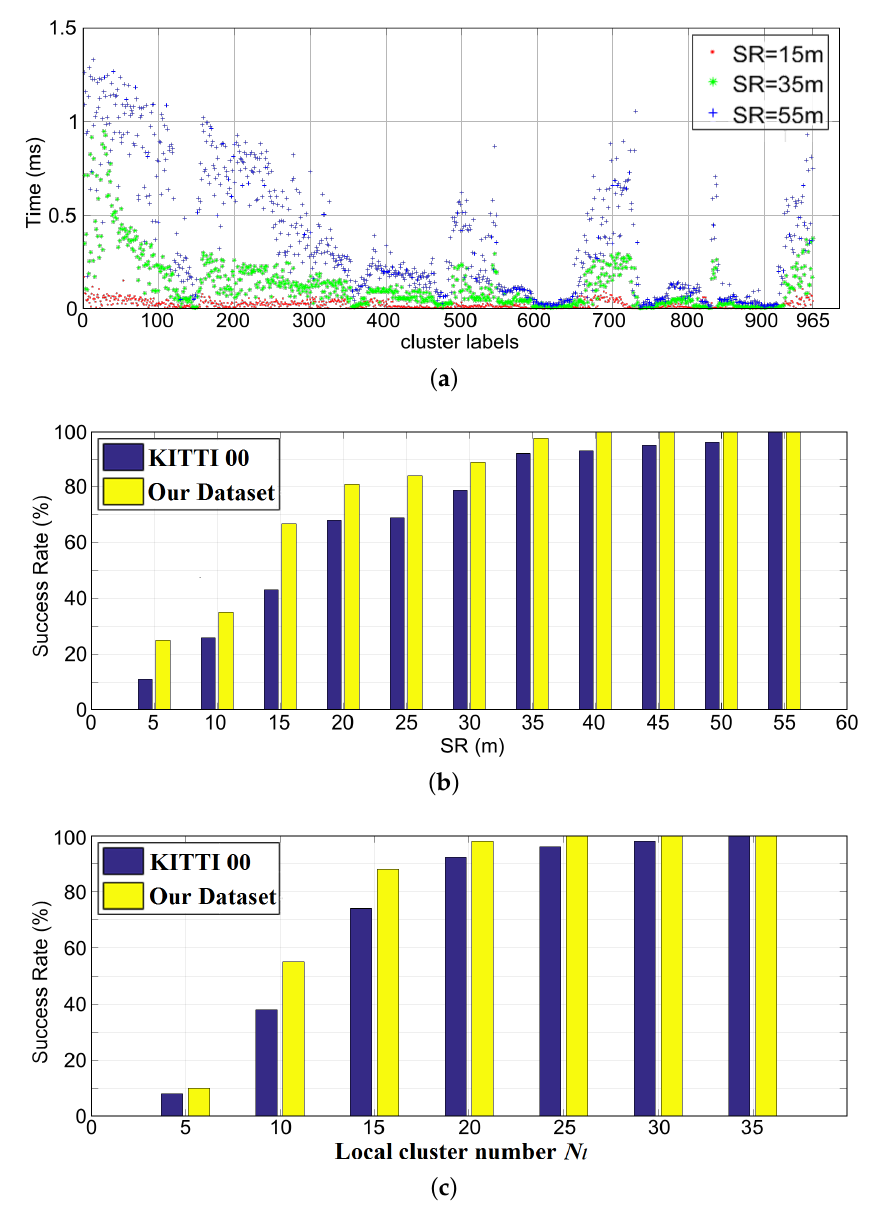
Figure 12. Performance evaluation of the algorithm parameters SR and cluster number N l in local ClusterMap. ( a ) Computation time of establishing each location descriptor under different SR values; ( b , c ) visualization of the success rate of relocalization versus different values of SR and N l